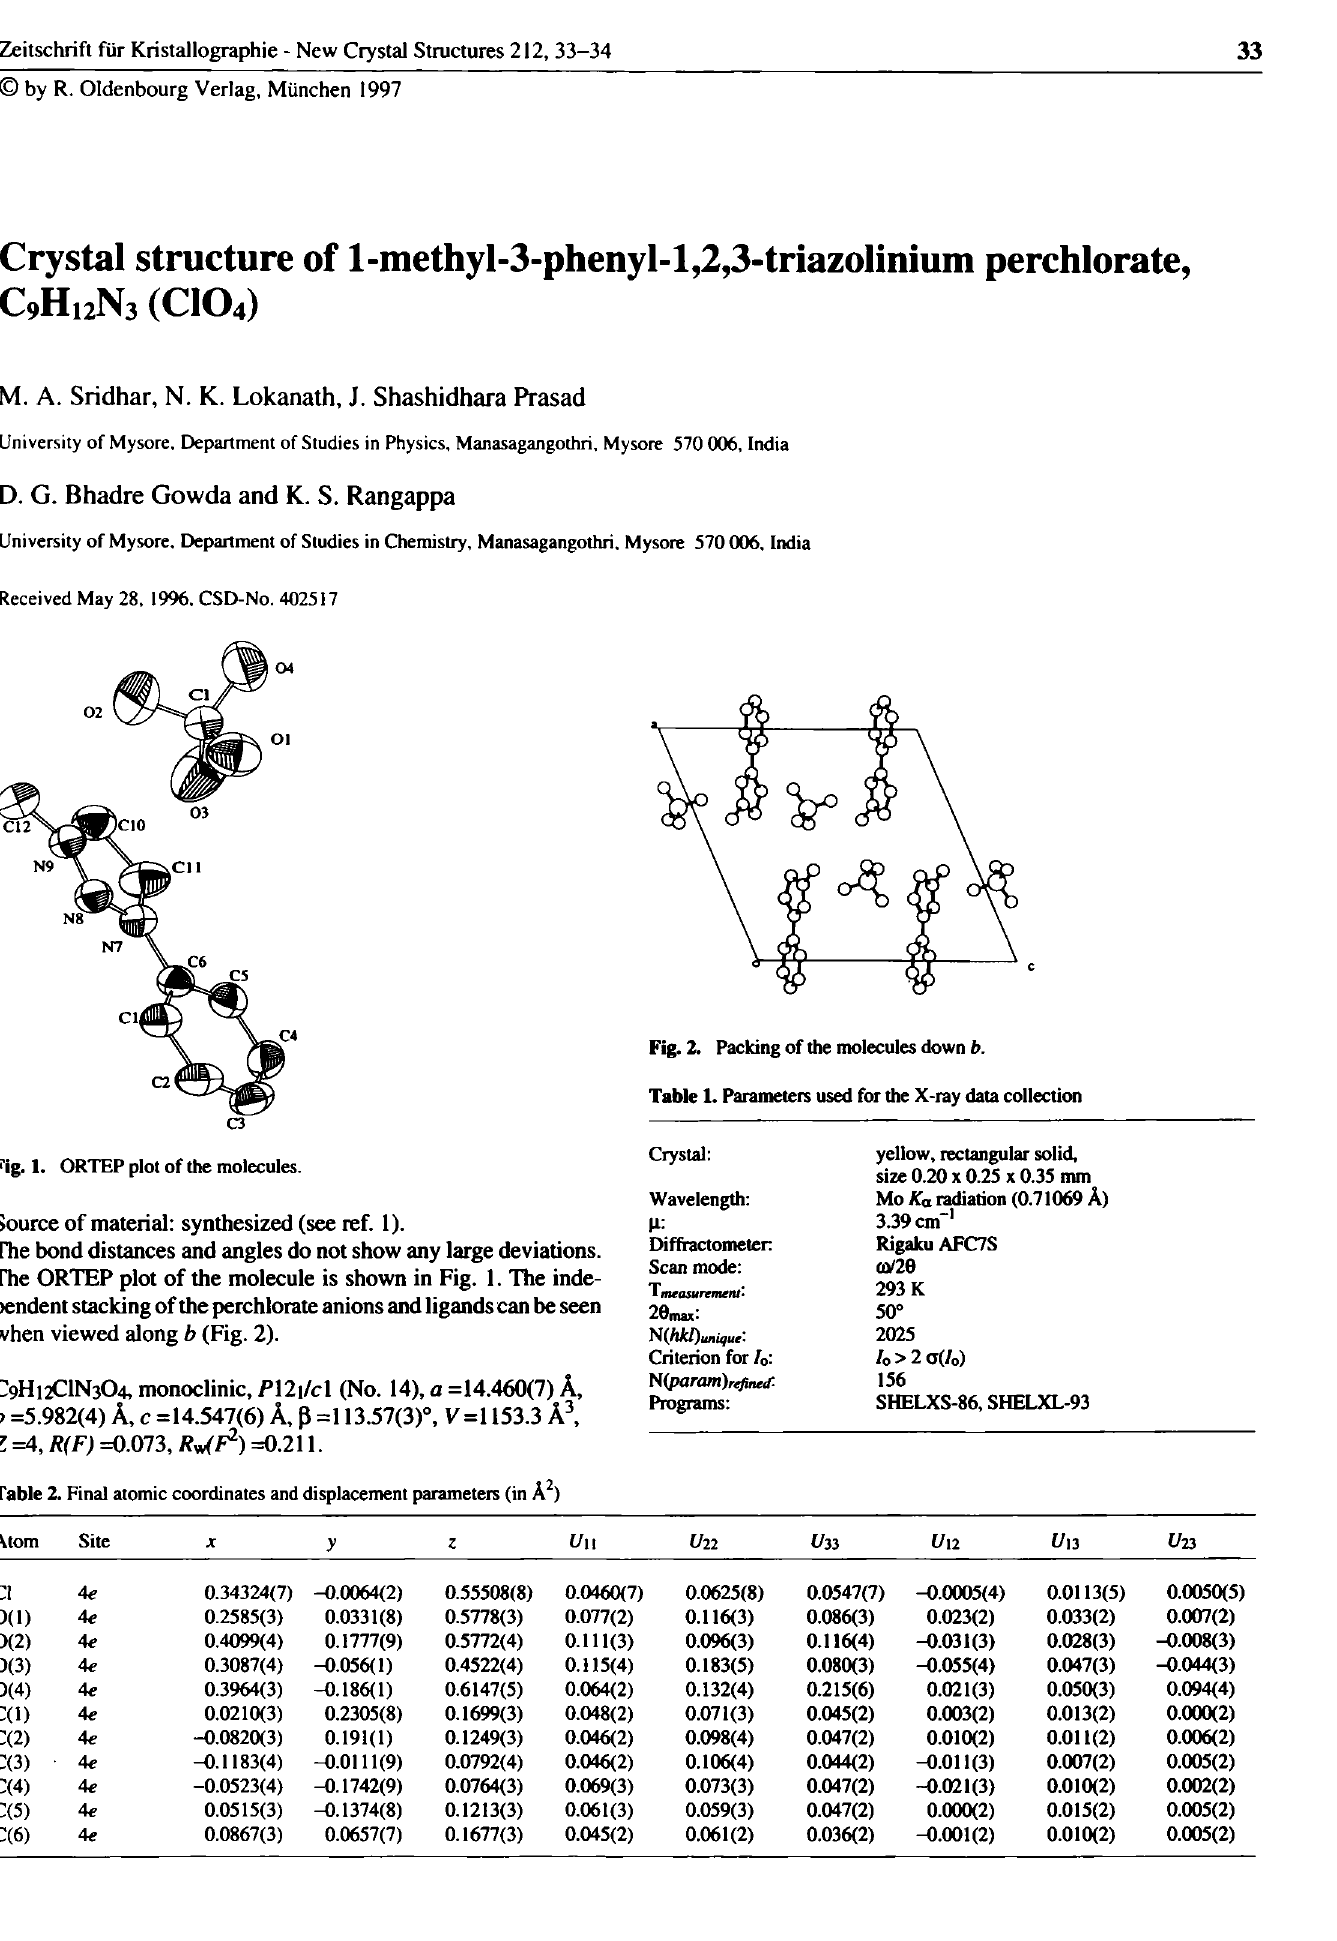
Fig. 1. ORTEP plot of the molecules. Source of material: synthesized (see ref. 1).